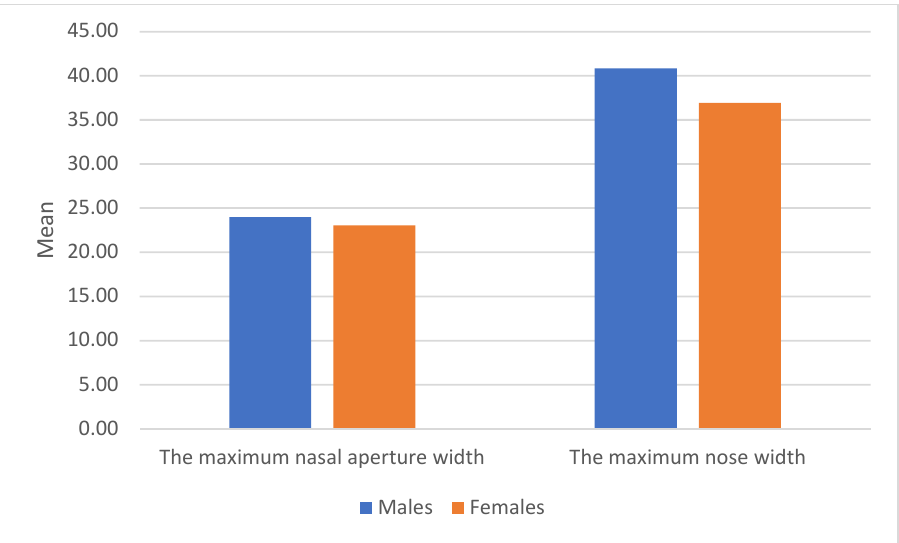
Figure 3. Differences between sexes for MAW and MNW. Figure 3. Di ff erences between sexes for MAW and MNW. Table 3. Correlations and partial correlations between the maximum width of the nasal aperture and the maximum width of the nose.